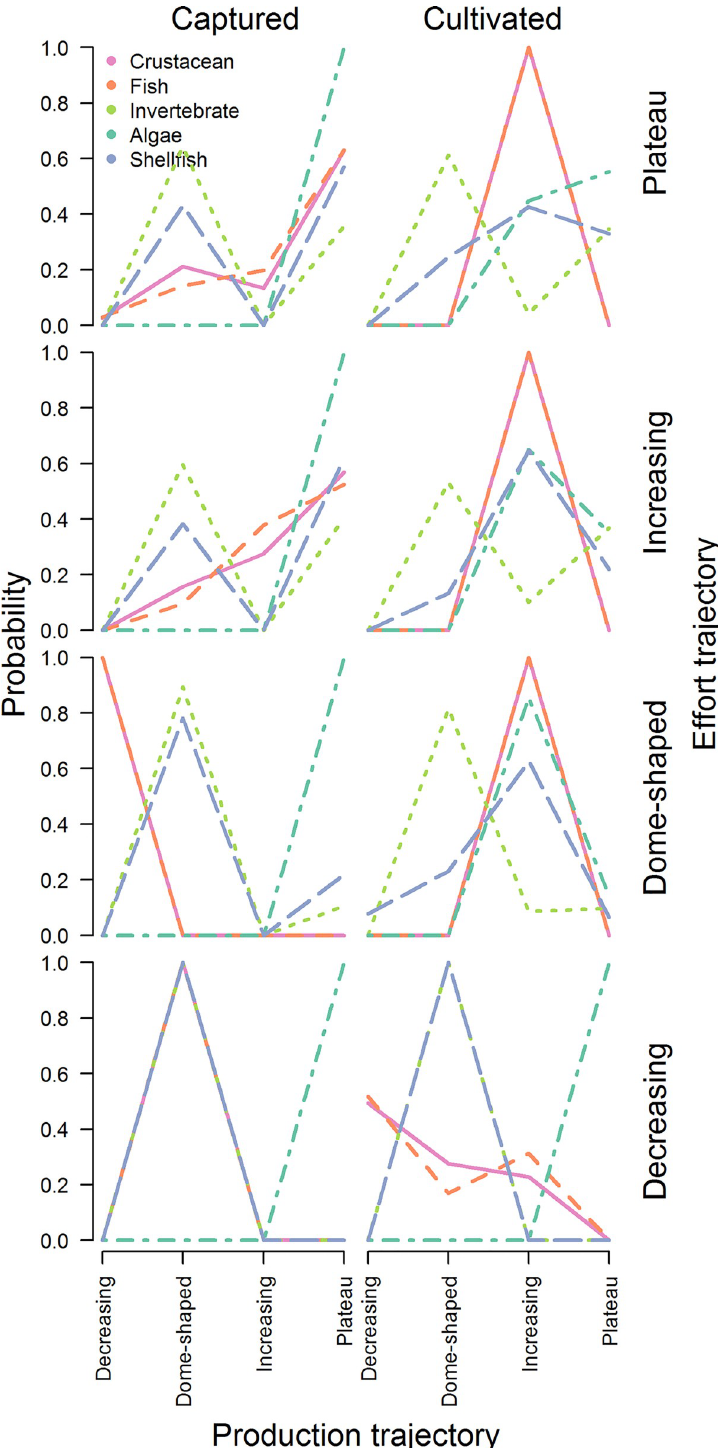
Fig 4. Probabilities of a production trajectory given production mode, product, and effort trajectory estimated via multinomial logistic regression. Probabilities sum to one for a given effort trajectory, product type, and production